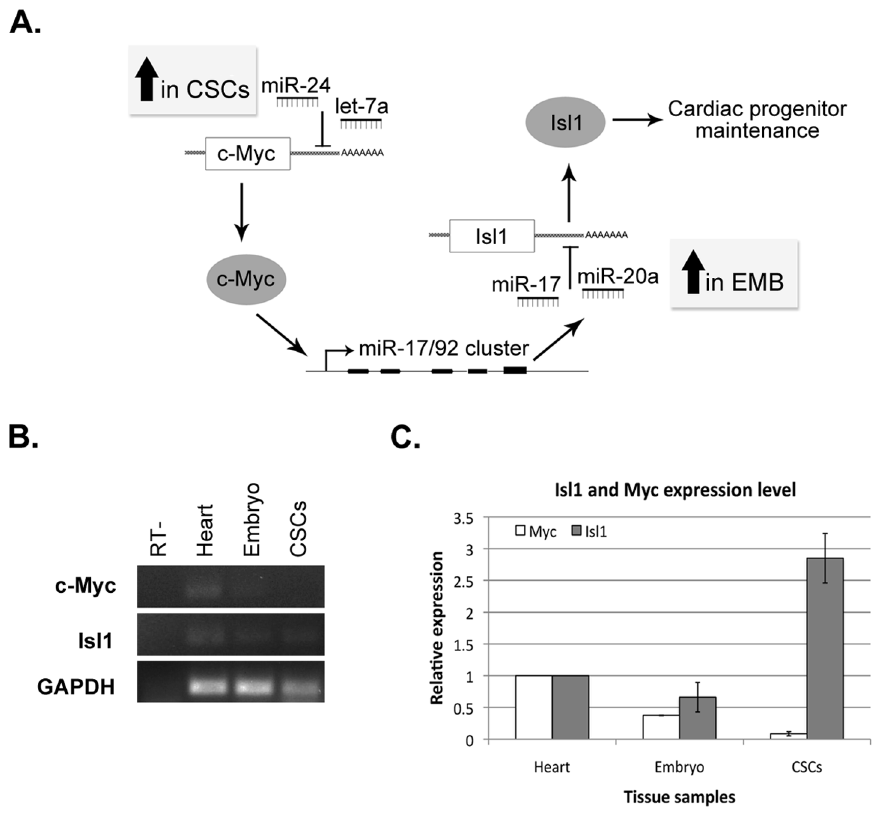
Figure 3. Expression of myc and Isl1 in CSCs. A. Proposed regulatory network involving differentially expressed miRs in embryonic heart (EMB) and CSCs. B. Expression of c-Myc and Isl1 in embryonic heart and CSCs by semi-quantitative RT-PCR. Results are representative of three independent replicate samples. C. Quantification of relative expression levels of c-Myc and Isl1 (n=3). Expression levels are normalized to GAPDH.